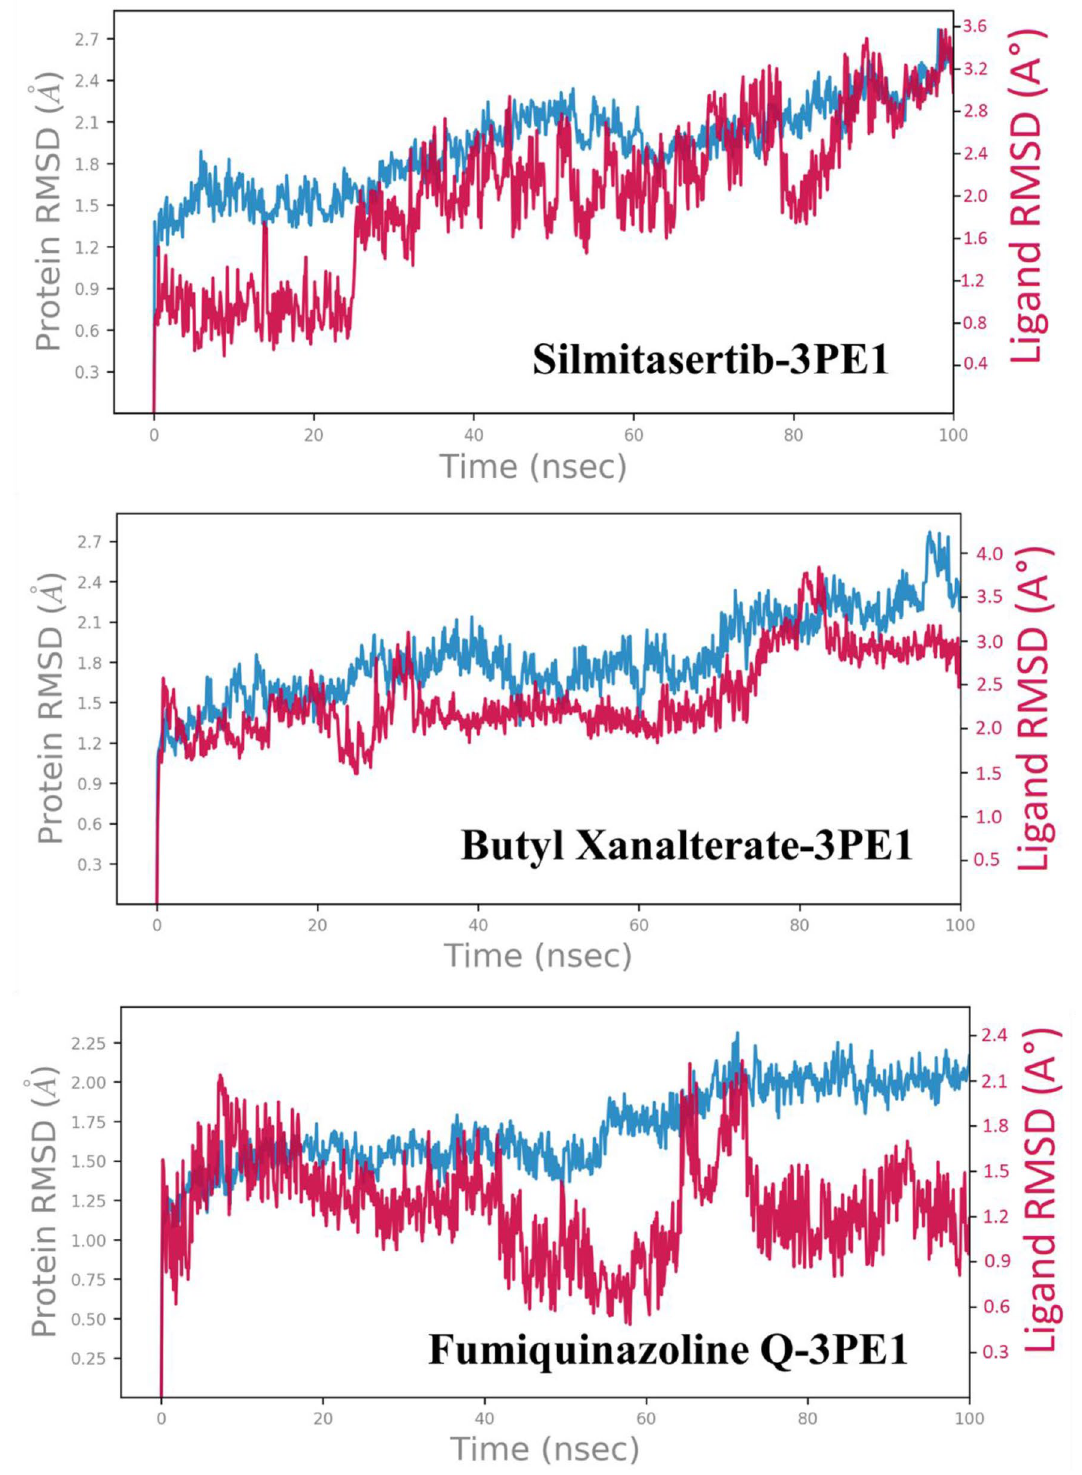
Figure 7. Protein and ligand RMSD for the trajectory of each system. Protein RMSD is shown in grey while Ligand RMSD is shown in